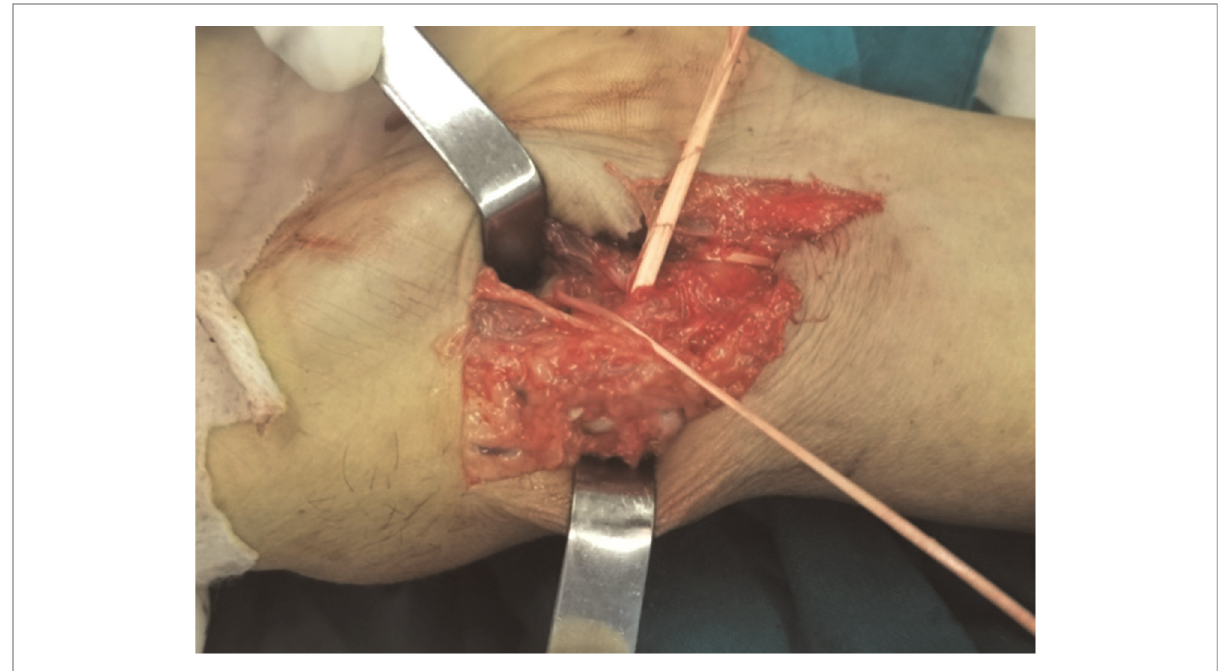
FIGURE 3 The radial half of the tendon is transected and dissociated distally to the level of the CMC